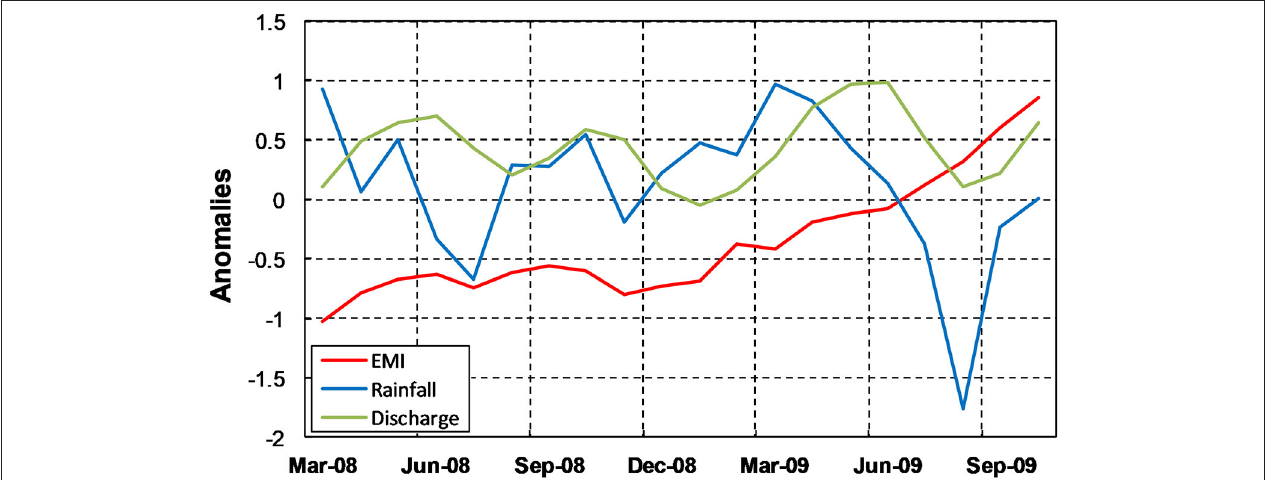
FIGURE 10 | Monthly normalized anomalies of rainfall (mm/month), computed over the area of 0 ◦ –12 ◦ N and 53 ◦ –70 ◦ W (blue line), Amazon River discharge (m 3 s − 1 ) (green line) and EMI (red line) shifted + 4 months. Anomalies of SST and rainfall were constructed over the period of 46 years.